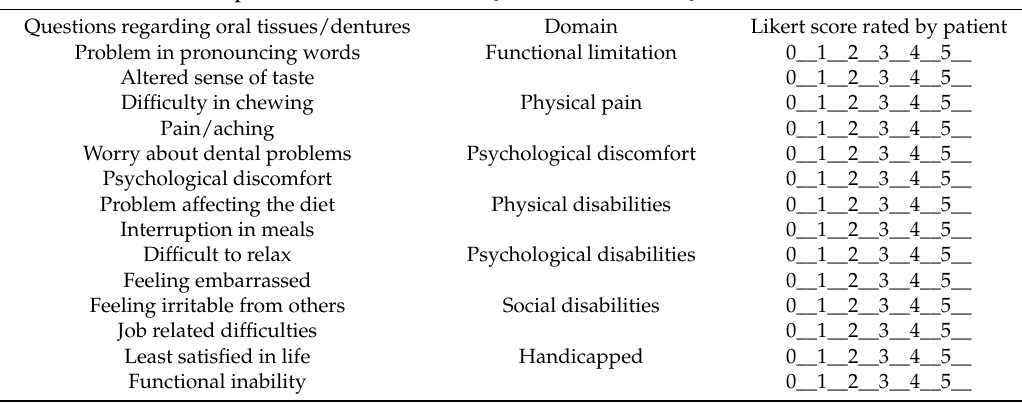
Table 2. The description of Quality of Life (QoL) questionnaire; Oral Health Impact Profile-14 (OHIP-14) criteria questions and domains used in this